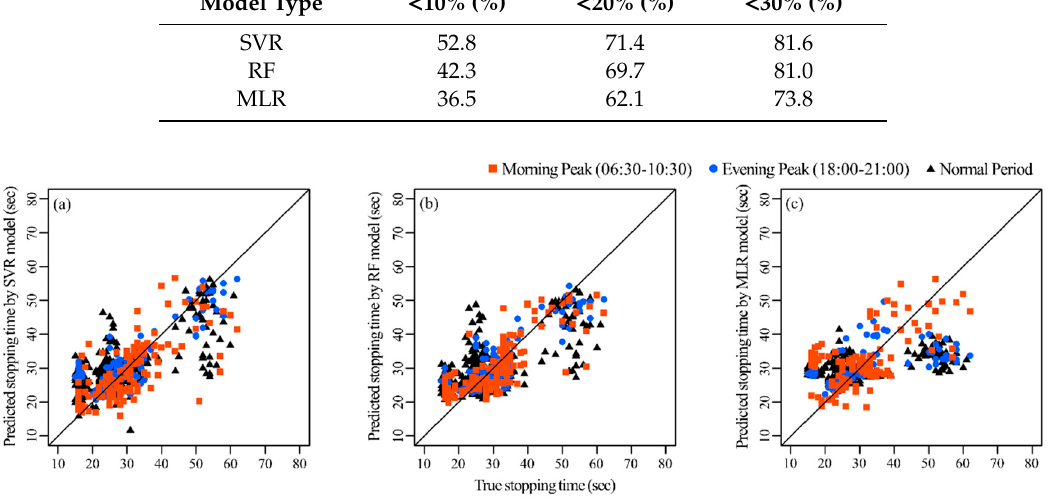
Figure 8. Dwell time estimation performance comparison among the ( a ) SVR, ( b ) RF, ( c ) MLR models.